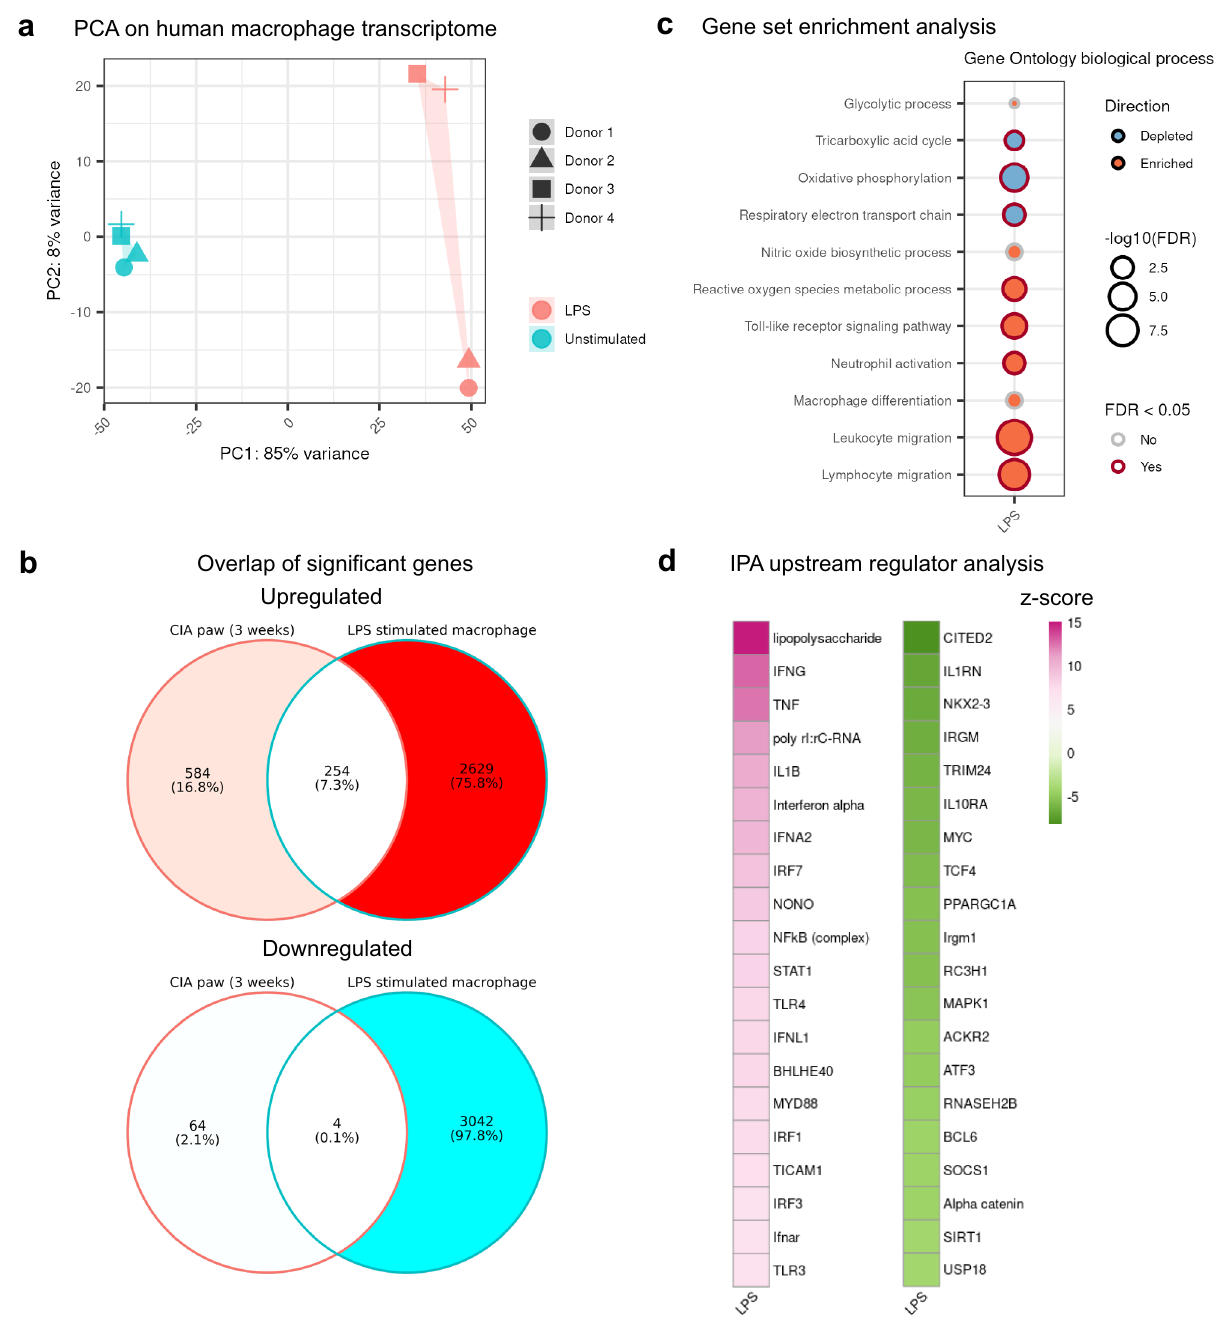
Figure 6. Transcriptional profiling of LPS-stimulated human macrophages partially overlaps to early transcript changes in mouse CIA. Bulk RNA-seq analysis of human monocyte-derived macrophages from four human donors. Stimulation was done with 50 ng/ml LPS for 24 h. ( a ) PCA score plot with four samples of human macrophages before and after LPS stimulation. ( b ) Overlap of significant differentially expressed genes between CIA paws at week 3 and LPS-stimulated macrophages. The Wald test in DESeq2 was performed for statistical analysis on macrophage dataset and LPS-stimulated samples were compared to the unstimulated. ( c ) Enriched or depleted Gene Ontology biological process gene sets. ( d ) Top 20 activated and top 20 inhibited upstream regulators from analysis by IPA. Only upstream regulators with Benjamini–Hochberg (B–H) adjusted p-values < 0.05 were shown with z-scores on a color gradient (activated: pink, inhibited: